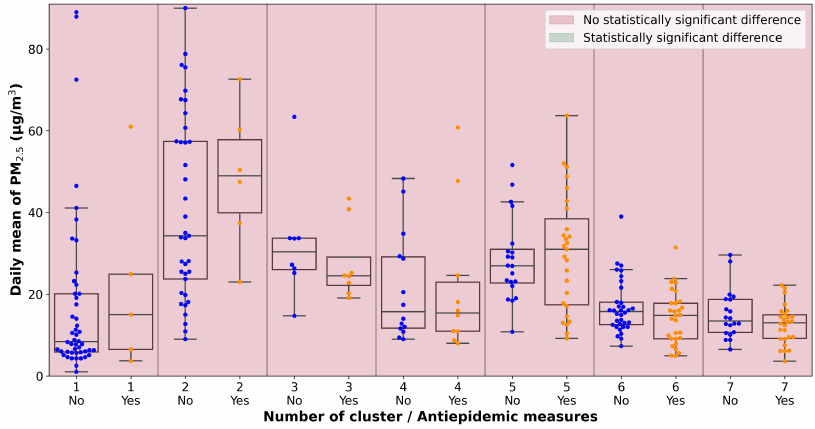
Figure 12. Results of the ANOVA test, Vˇeˇrˇnovice, PM 2.5 .